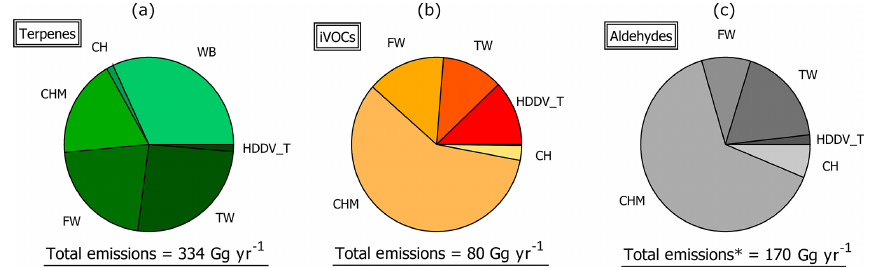
Figure 10. Total estimated emissions and relative distributions in the anthropogenic sources measured in Côte d’Ivoire for the VOC family. (a) Terpenes. (b) IVOCs. (c) Aldehydes (* for aldehyde species > C 6